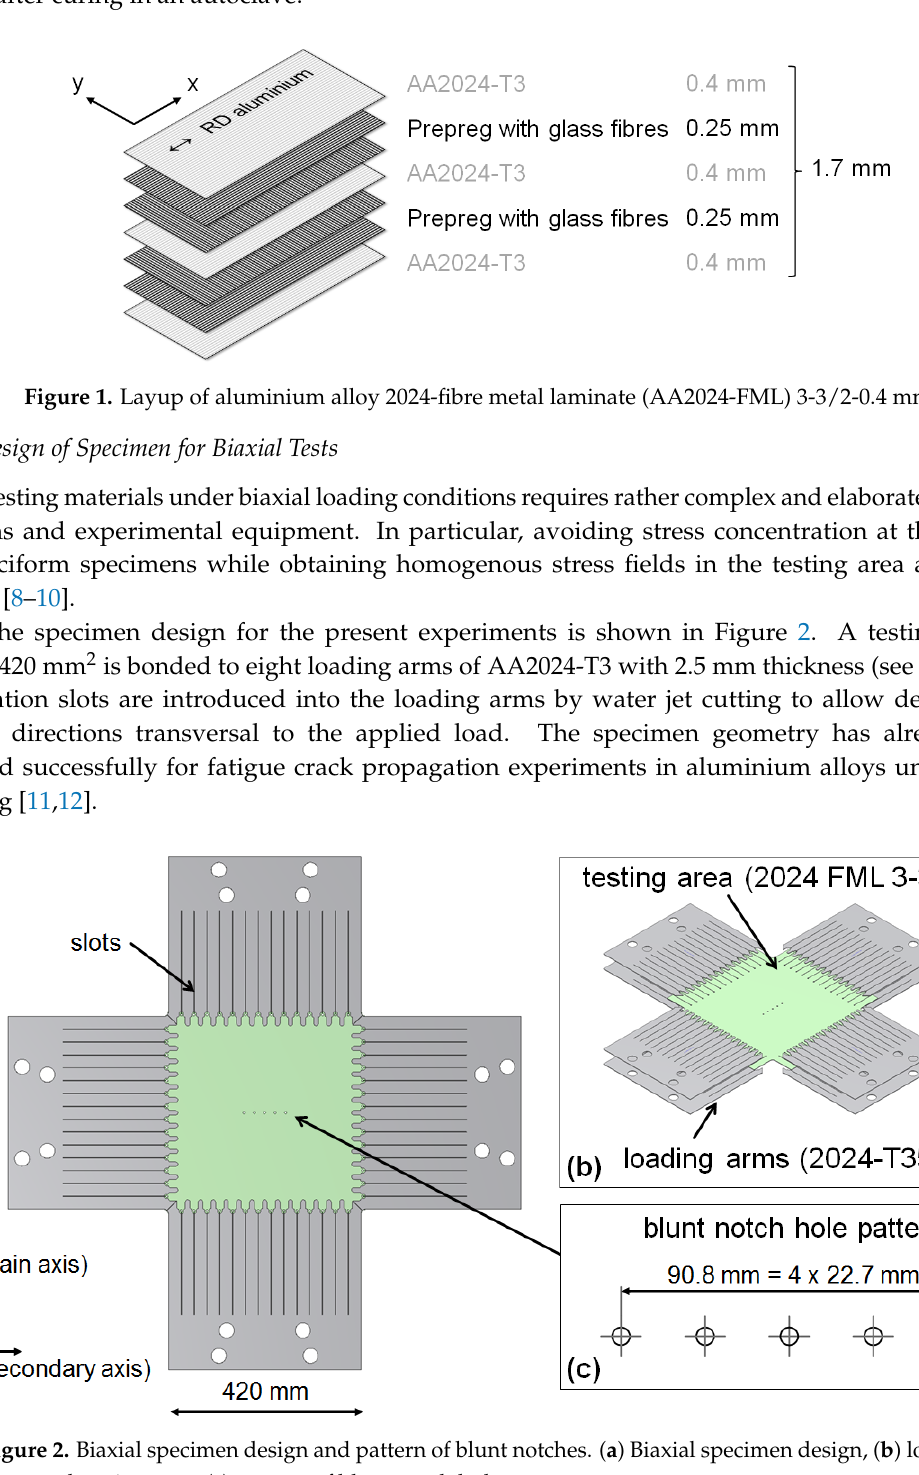
Figure 3. Off-axis angle for the biaxial test specimens with respect to the rolling direction of the aluminium alloy sheets and the fibre directions. 3. Biaxial Tensile Tests 3.1. Experimental Setup The biaxial testing machine, shown in Figure 4, consists of four hydraulic cylinders. The two loading axes are formed by two opposing cylinders. The main axis and the orthogonally arranged secondary axis have static load capabilities of 1,000 kN and 630 kN, respectively. Each cylinder is equipped with a load cell and a displacement sensor. Table 1 summarizes the details of the experimental setup. A 3D digital image correlation system (DIC) was used to determine the displacement and strain fields in the speci men’s testing area. Both cameras of the stereo DIC system were positioned above the biaxial testing machine pointing at the specimen’s upper surface. For details regarding the DIC system and the gauge area, see Table 1. The cruciform specimens were prepared with a stochastic black & white pattern for the determination of the strain fields using the described DIC system. The testing area (green section in Figure 2) was first sprayed with a white ground coat and then speckled with black points. The DIC system was set to take images automatically during loading of the specimen. A stack of 300 to 400 images were recorded for each experiment. The loading of the specimen was carried out by controlling the displacement of the main axis at a rate of 1 mm/min, while the force in the secondary axis was controlled following the force signal of the main axis to achieve the planned biaxiality ratio for the experiment.